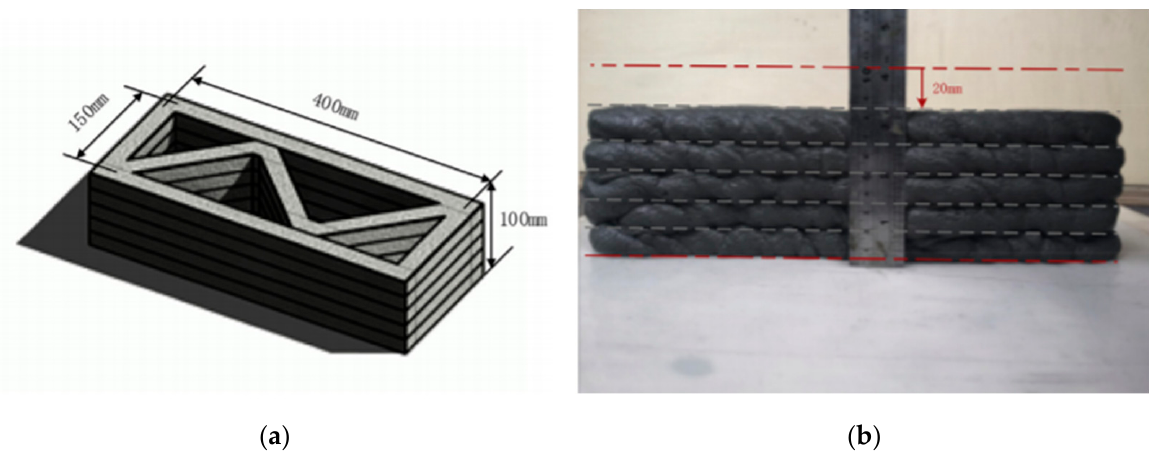
Figure 6. Print shape adopted for evaluating the buildability. ( a ) Shape map. ( b ) Evaluation Chart. Reprinted with permission from ref. [30]. Copyright 2019 Elsevier